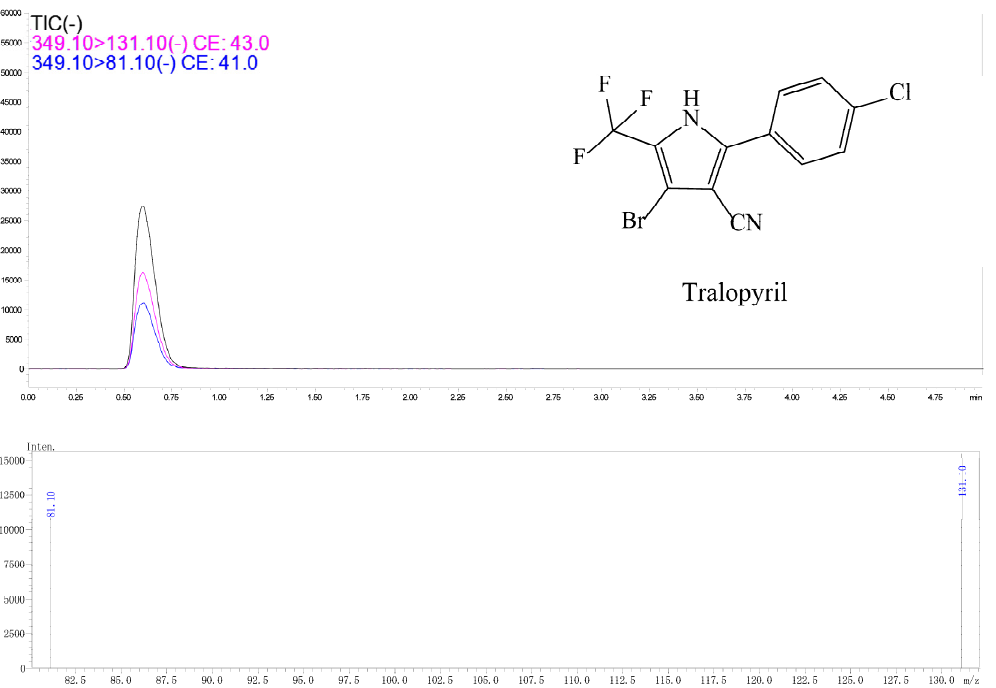
Figure 4. Typical spectra of tralopyril in radish leaf matrix extract detected by UPLC-MS/MS. The concentration of tralopyril was 0.1 mg/L.